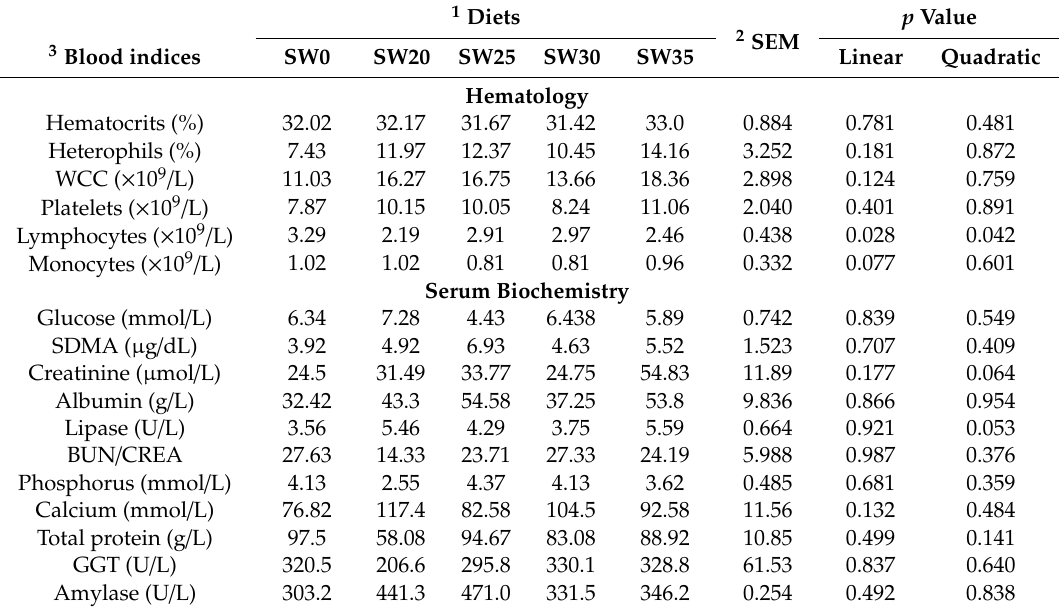
Table 4. The e ff ects of seaweed meal-containing diets on hematological and serum biochemical parameters of Cobb 500 broiler chickens.